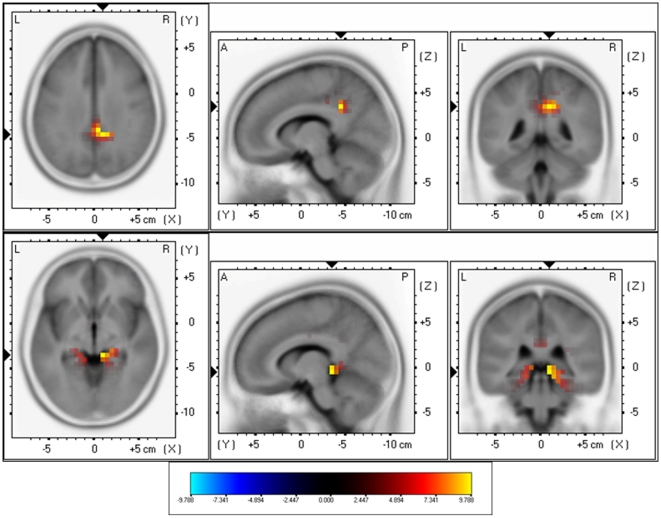
sLORETA contrast analysis between Narrow-Band-Noise tinnitus patients versus Control subjects (p<.05).Increased activity within Beta (25–30 Hz; Top Panel) in the posterior cingulate cortex (PCC; BA31) and Gamma (30.5–45 Hz; Bottom Panel) in the right and left parahippocampal areas (BA35) for bilateral narrow band tinnitus in comparison to controls.